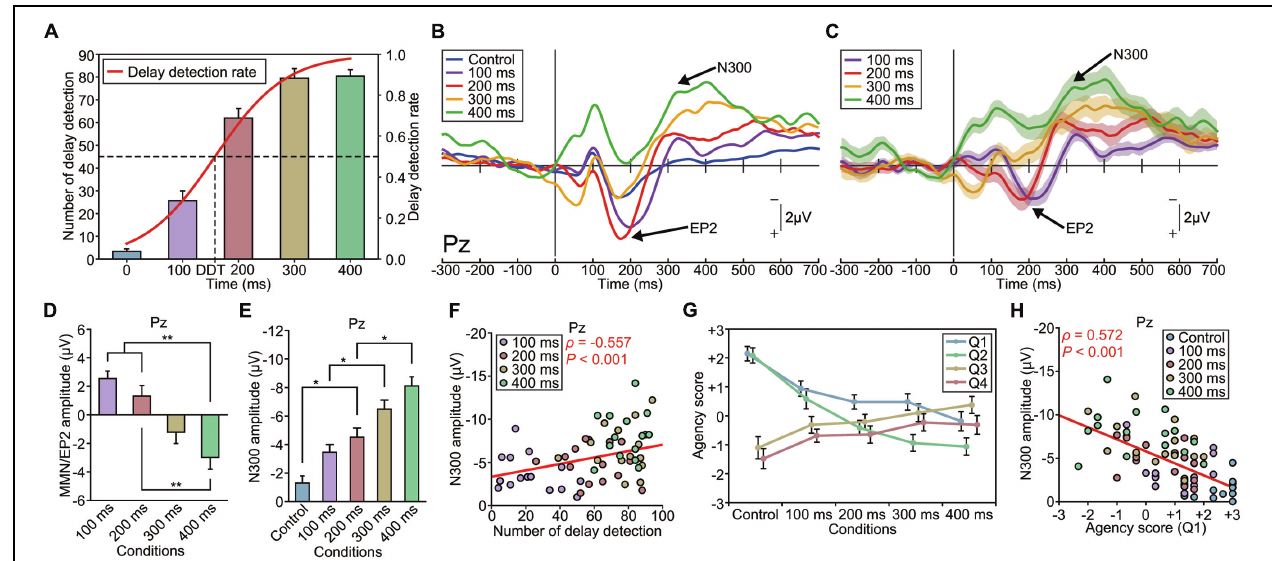
FIGURE 5 | Modulation of the EP2 and N300 by delay length (Experiment 4). (A) The number of auditory feedback delays that the participant detected increased as a function of the delay length. Delay detection probabilities were fitted to a logistic function. The delay detection threshold (DDT), where the probability is 50%, was estimated to be 158 ms. (B) Grand-averaged ERP waveforms at Pz ( n = 16). Deviant auditory feedback was delayed by either 0 ms (control), 100, 200, 300, or 400 ms, with each delay size presented in a separate session. (C) Differential (deviant – standard) ERP waveforms. Shaded areas represent SEM. (D) The amplitude of the EP2 (MMN) was significantly modulated by the delay length. A one-way ANOVA revealed a main effect of delay [Pz: F ( 3 , 60 ) = 10.70, p < 0.001, effect size η 2 = 0.35]. A post hoc analysis (Tukey’s HSD test) revealed a significant difference between the 100/200-ms-delay and 400-ms-delay conditions. Notably, the P2 was enhanced in the shorter-delay ( ≤ 200 ms) conditions while the MMN was present in the longer-delay ( ≥ 300 ms) conditions. (E) The amplitude of the N300 was significantly modulated by the delay length [Pz: F ( 4 , 75 ) = 18.30, p < 0.001, effect size η 2 = 0.49]. A post hoc analysis (Tukey’s HSD test) indicated that the absolute amplitude of the N300 was significantly larger in the 300 and 400-ms-delay conditions compared with the other conditions. (F) The N300 amplitude was significantly correlated with the rate of subjective detection of the auditory feedback delay. A correlation analysis showed a significant correlation between the amplitude of the N300 at Pz and the counted number of delayed stimuli ( ρ = − 0.557, p < 0.001, Spearman’s rank correlation coefficient). (G) We assessed the sense of agency via a questionnaire: Q1 and Q2 concerned the sense of agency, while Q3 and Q4 served as dummy questions (see Materials and Methods). The sense of agency was attenuated as the delay length increased. A one-way ANOVA revealed a significant effect of the delay [Q1: F ( 4 , 75 ) = 9.22, p < 0.001, effect size η 2 = 0.33; Q2: F ( 4 , 75 ) = 18.91, p < 0.001, effect size η 2 = 0.50]. A post hoc analysis exposed significant differences between the shorter-delay conditions and the longer-delay conditions. (H) A correlation analysis revealed a significant correlation between the amplitude of the N300 at Pz and the agency score (Q1: ρ = 0.572, p < 0.001, Spearman’s rank correlation coefficient). A similar result was obtained for Q2 ( ρ = 0.545, p < 0.001). ∗ p < 0.05, ∗∗ p < 0.01. Error bars represent